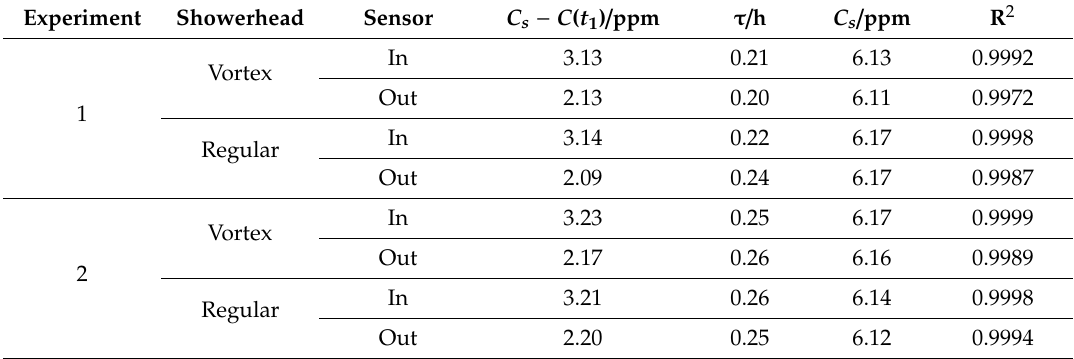
Table 1. Fitting parameters of equation 1 to data of the DO (dissolved oxygen) content for two identical experiments of regular and vortex showerheads before and after the shower using a least-squares method. t 1 indicates the start of the shower spray. C s is the saturation concentration for oxygen found by the fit and C ( t 1 ) is the concentration at time t 1 . The goodness of fit is indicated with R 2 . Experiment Showerhead